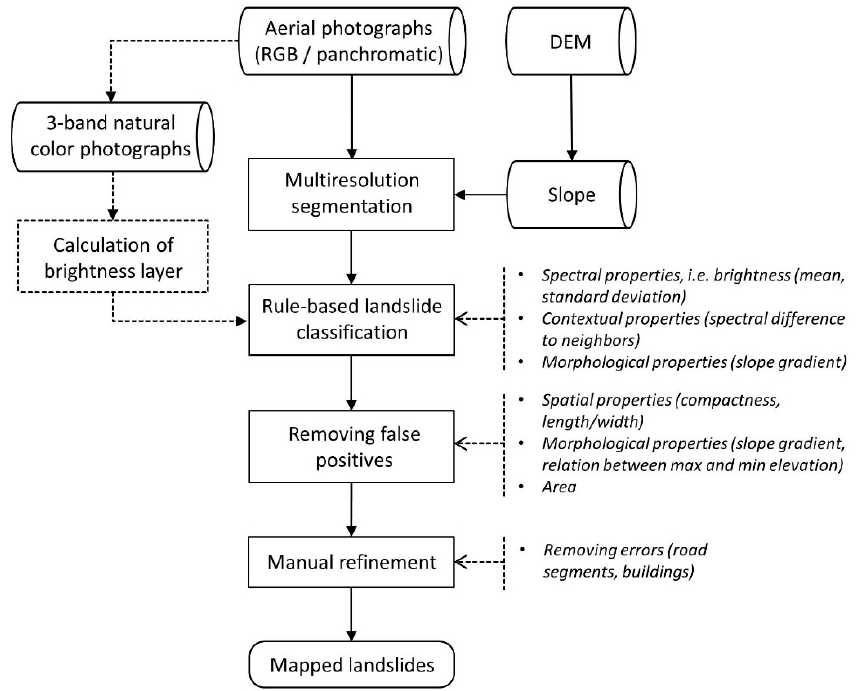
Figure 3. Object-based landslide mapping workflow. DEM, digital elevation model; RGB, red, green, blue.